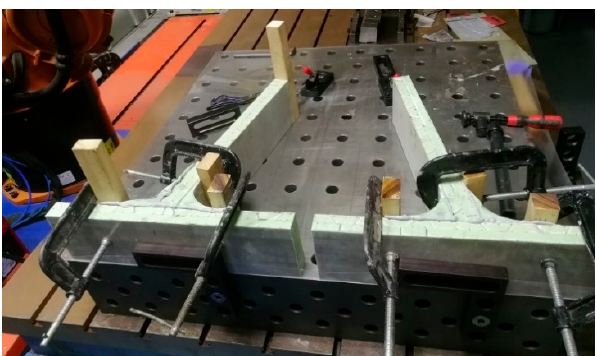
Figure 4. Bonding of T-joint.